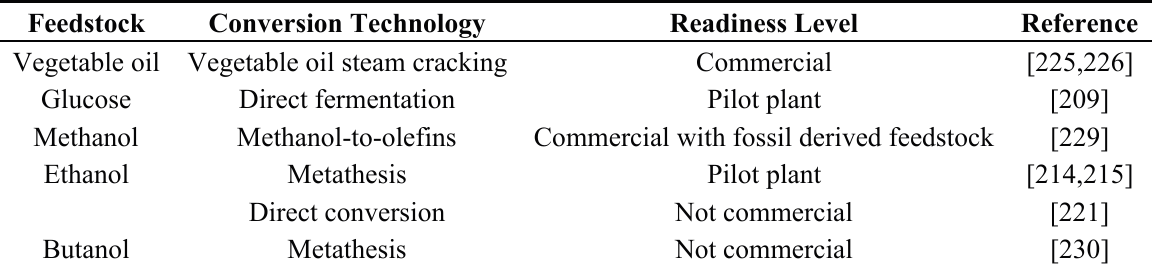
Table 2. Potential sources of bio-based propylene for the synthesis of